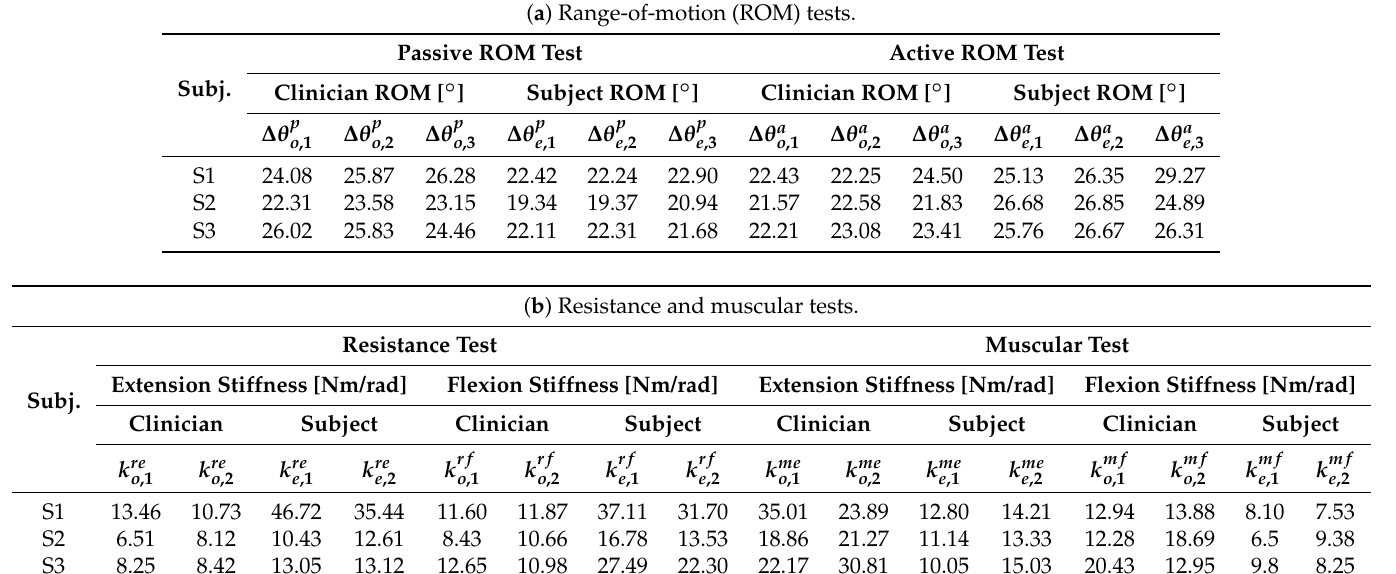
Table 2. Results of the preliminary experimental tests for each subject and each repetition. The parameter ∆ θ (a) represents the angular range of motion at the MCP joint, whereas k (b) represents the stiffness of the hand. The subscripts o , e indicate the side of the system where the parameter is measured (operator, i.e., clinician; environment, i.e., patient); the subscripts from 1–3 identify the repetition of the test; the superscripts indicate the type of test: for the range of motion tests, passive ( p ) and active ( a ); for both the resistance ( r ) and muscular test ( m ), extension ( e ) and flexion ( f